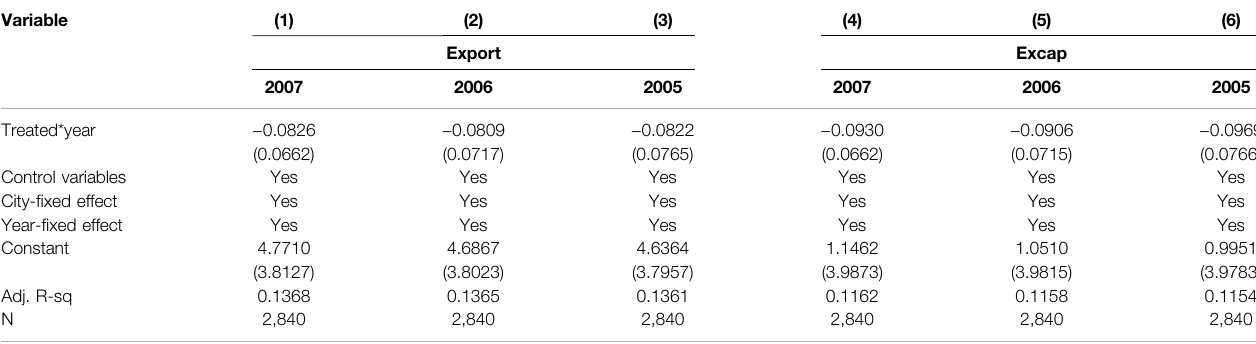
TABLE 5 | Placebo tests with false policy time.